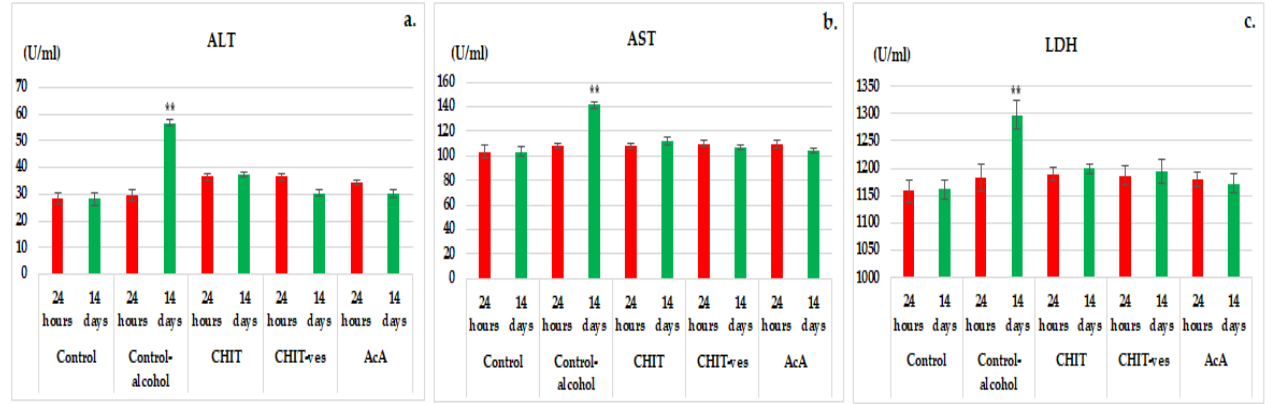
Figure 5. The effects of chitosan, chitosan vesiclesand ascorbic acidon the activity of ALT ( a ), AST ( b ) and LDH ( c ) in mice. The values are expressed as mean ± S.D. of the average values for 6 animals per group. ** p <0.01.